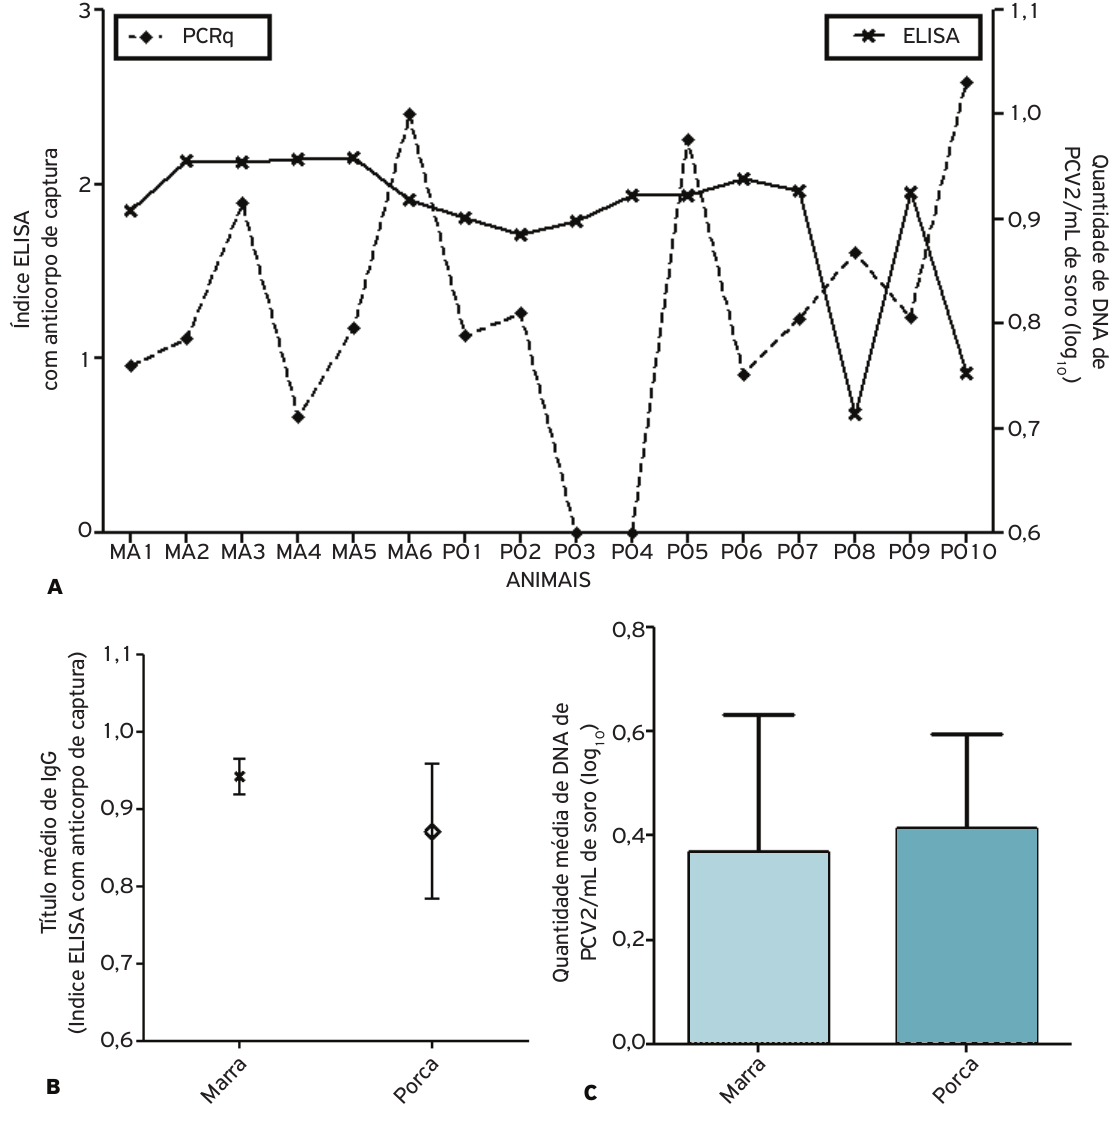
B Figura 1. Dados referentes ao status imunológico e virêmico das 16 fêmeas (6 marrãs e 10 porcas) selecionadas na granja. (A) Leitura do índice ELISA com anticorpo de captura para IgG anti-PCV2 e quantidade de DNA/mL de soro de PCV2 (log fêmeas selecionadas na propriedade, (B) Média da leitura do índice ELISA com anticorpo de captura para IgG anti-PCV2 e o desvio padrão, (C) Média da quantidade de DNA de PCV2/mL e desvio padrão.